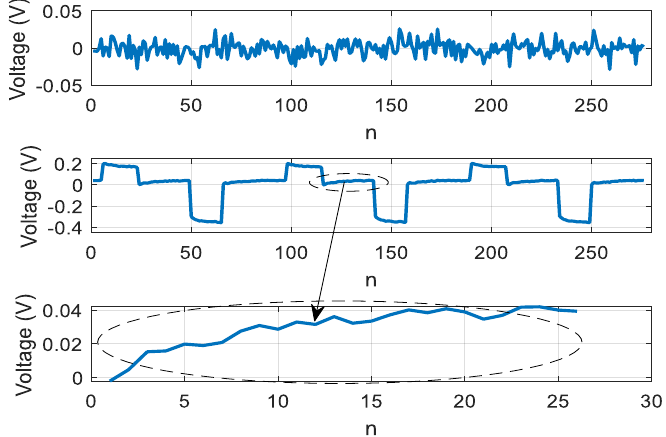
Figure 10. Dependence of the extracted signal on discrete time 𝑛 = 𝑡 Δ𝑡⁄ , Δ𝑡 = 1𝜇𝑠, implying an extraction obtained using the combined criterion based on skewness and kurtosis.